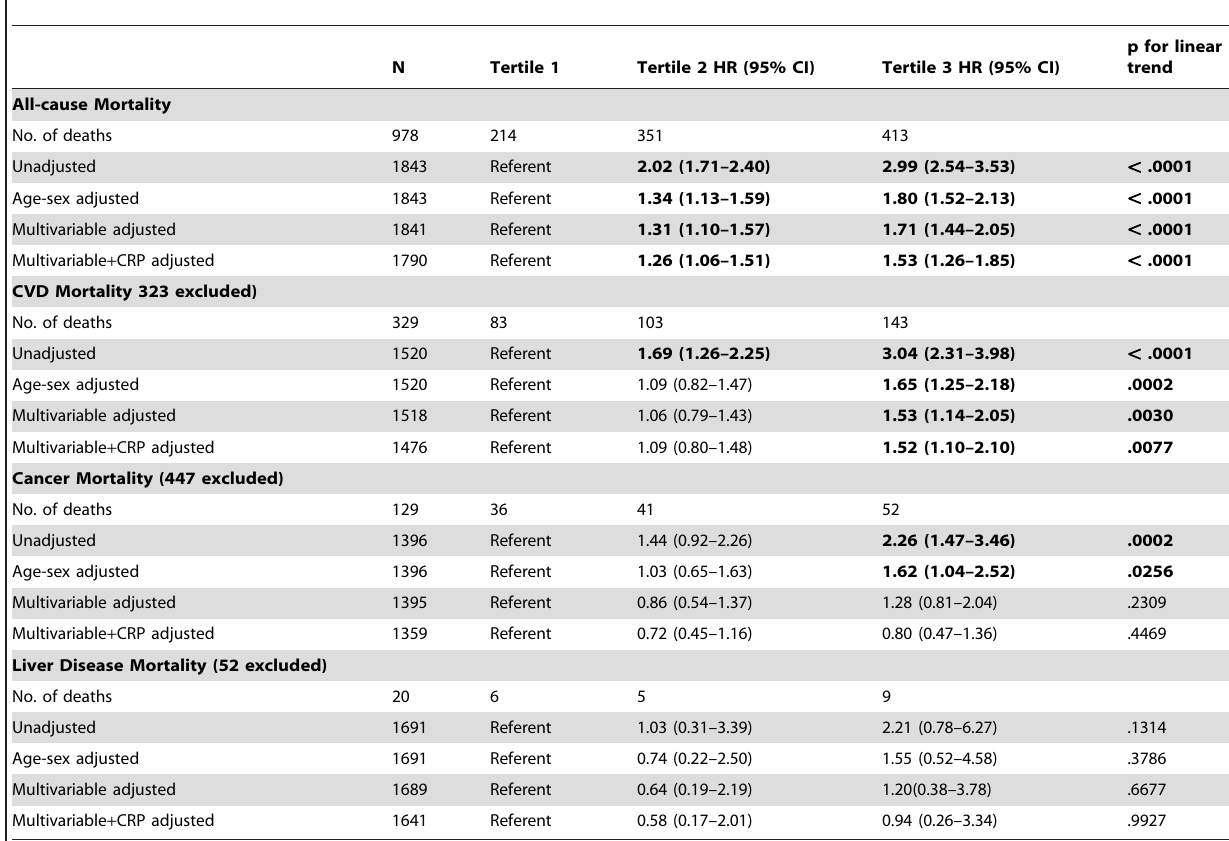
Table 3. Hazard ratios of all-cause, cardiovascular, cancer, and liver mortality stratified by IL-6 tertiles over 15 years of median follow-up (excluding individuals with prevalent CVD, cancer, and liver